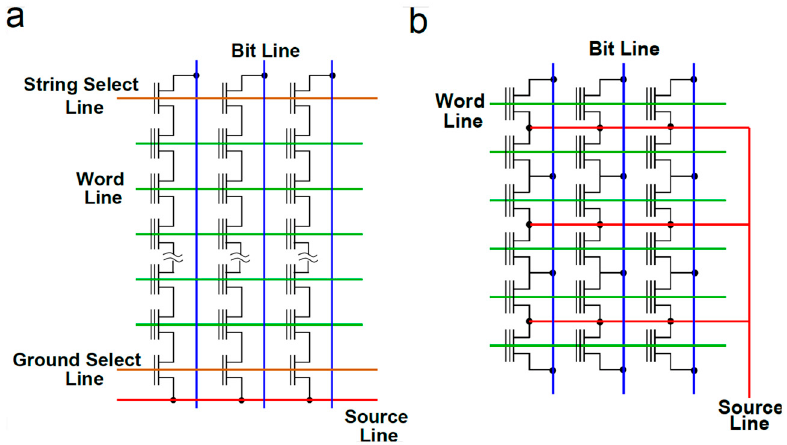
Figure 4. Physical mechanisms and corresponding voltage schemes exploited to change the amount of charge in the cell storage layer, consisting of ( left ) Fowler–Nordheim (FN) and ( right ) channel hot ‐ electron injection (CHEI).